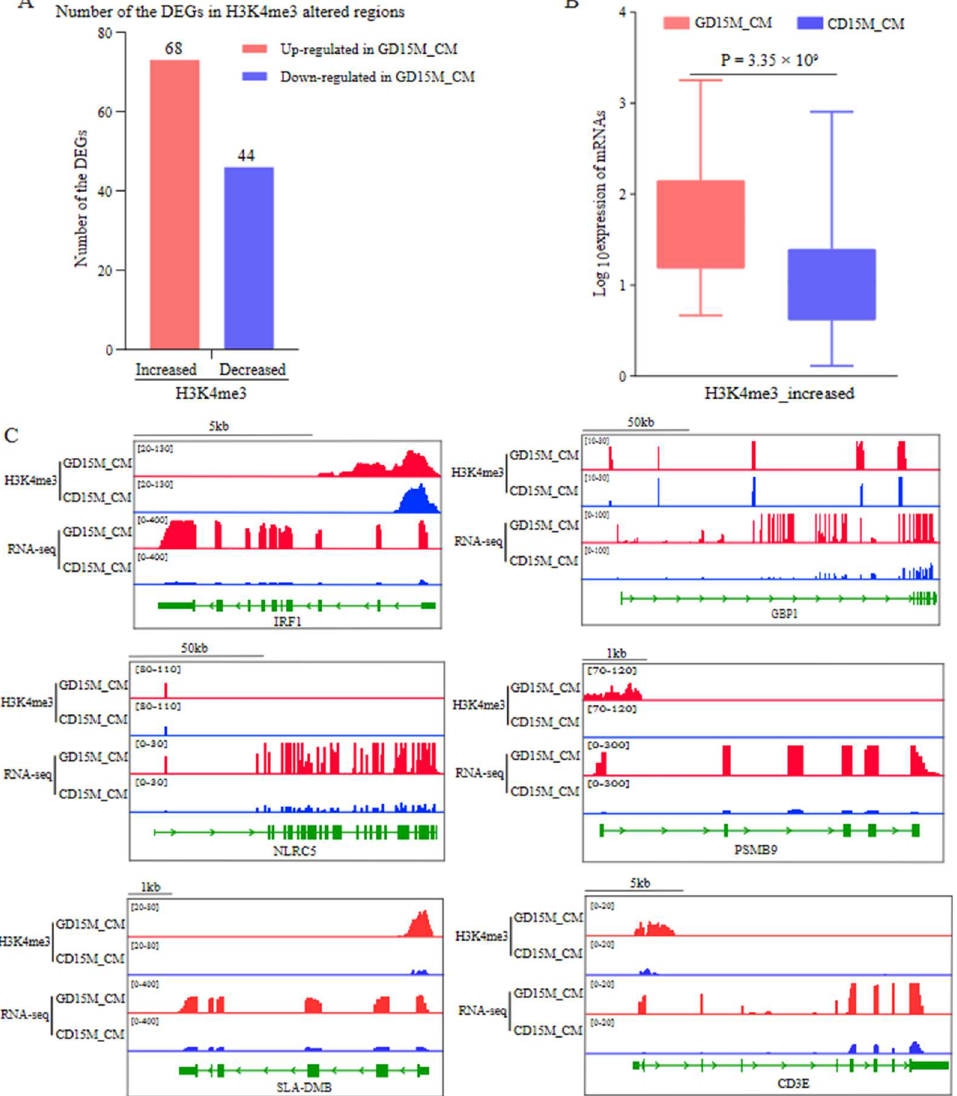
Figure 6. Relationships of H3K4me3 and H3K27ac modifications with the DEGs between the M_CM on GD15 and CD15. ( A ) Number of DEGs containing H3K4me3-increased or -decreased regions. ( B ) Box plots of the expression value of the upregulated genes in GD15M_CM that H3K4me3 modified. ( C ) IGV views of the H3K4me3 modification patterns. GD15, day 15 of pregnancy; CD15, day 15 of the estrous cycle; M, the mesometrial side of the uterus; CM, the circular muscle of myometrium; DEGs, differentially expressed